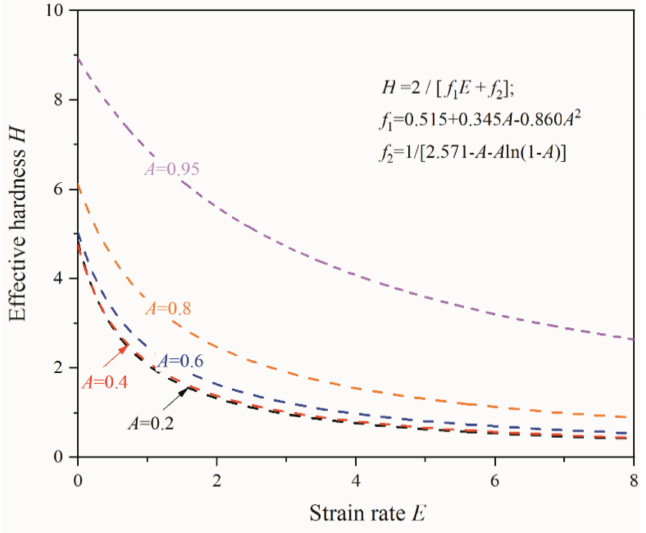
Figure 12. Variation of non-dimensional effective hardness ( H ) as a function of non-dimensional strain rate ( E ) given contact area ratios of 95%, 80%, 60%, 40%, and 20%.